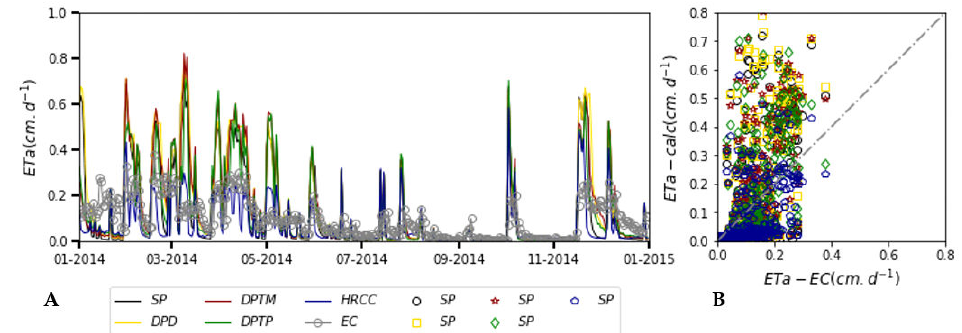
Figure 11. Comparison between the ETa estimated by the models ( A ) and the measurement by eddy covariance ( B ) in the Pasture